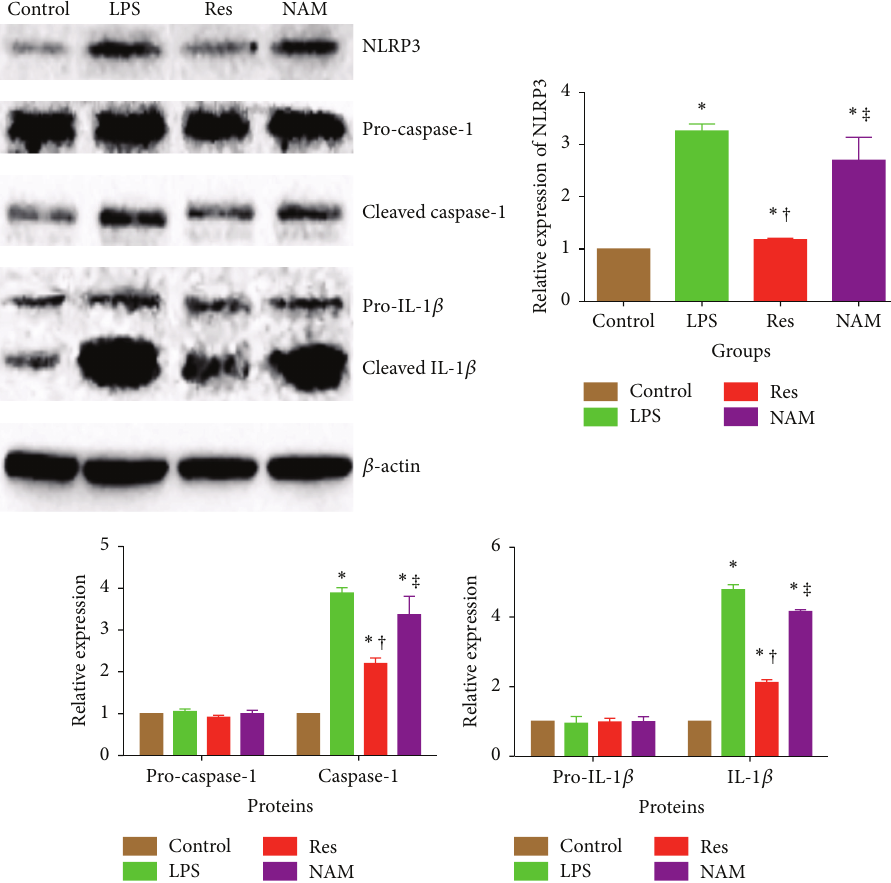
Figure 6: In vitro assay of the effects of Sirt1 inhibitor, NAM, on the protective effects of resveratrol in BV2 cells. Blots portray protein expression of NLRP3, caspase-1, and IL-1 𝛽 . All immunoblots were normalized to the loading control, 𝛽 -actin. This population of BV2 cells was treated with resveratrol, either in the presence or in the absence of nicotinamide. Control cells were stimulated with ATP alone, while LPS cells were stimulated with both ATP and LPS. Res cells were treated with one dose of resveratrol at a concentration of 30 𝜇 M, in the presence of both ATP and LPS. NAM cells were treated with the same dose of resveratrol (30 𝜇 M) but in the presence of nicotinamide (10mM), ATP, and LPS. ∗ 𝑃 < 0.05 compared with control group, † 𝑃 < 0.05 compared with LPS group, and ‡ 𝑃 < 0.05 compared with Res group, by one-way ANOVA and LSD tests. Bars represent the mean ±